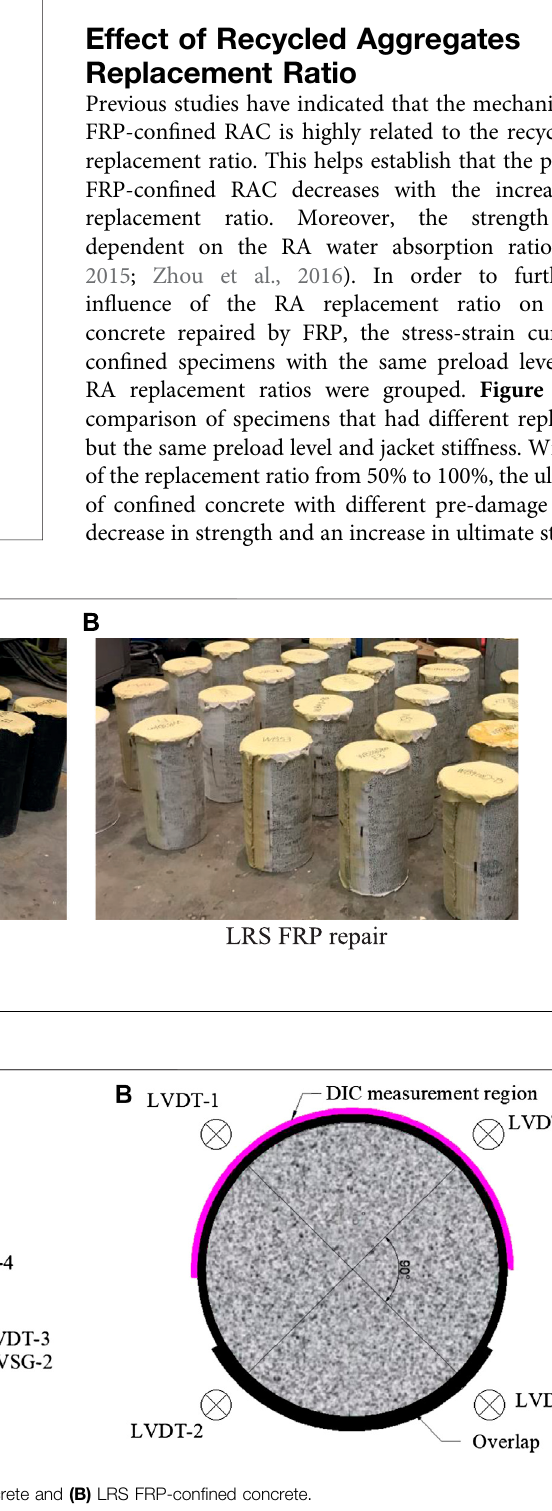
Frontiers in Materials |